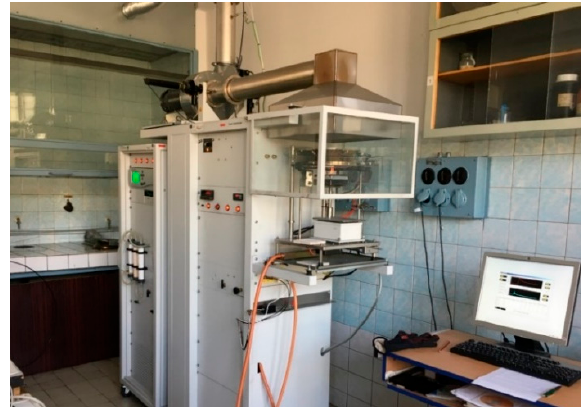
Figure 2. Cone calorimeter.